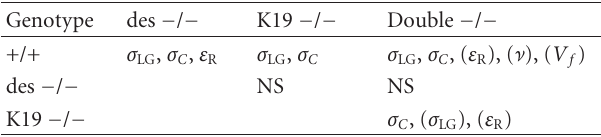
Table 2: Summary of parameters that display significant post hoc di ff erences ( P < 0 . 05) between genotypes for fibers harvested from aged mice. Raw data, means, and standard errors are provided in Figure 1. Parameters that display non-significant trends ( P < 0 . 09) are provided in parentheses. NS: No significant di ff